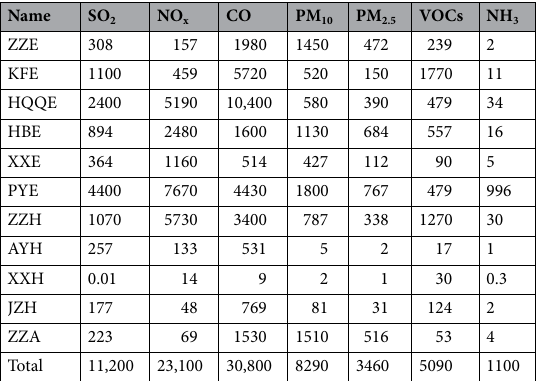
Table 3. The emissions of seven air pollutants in 11 parks in 2017 (unit: t).